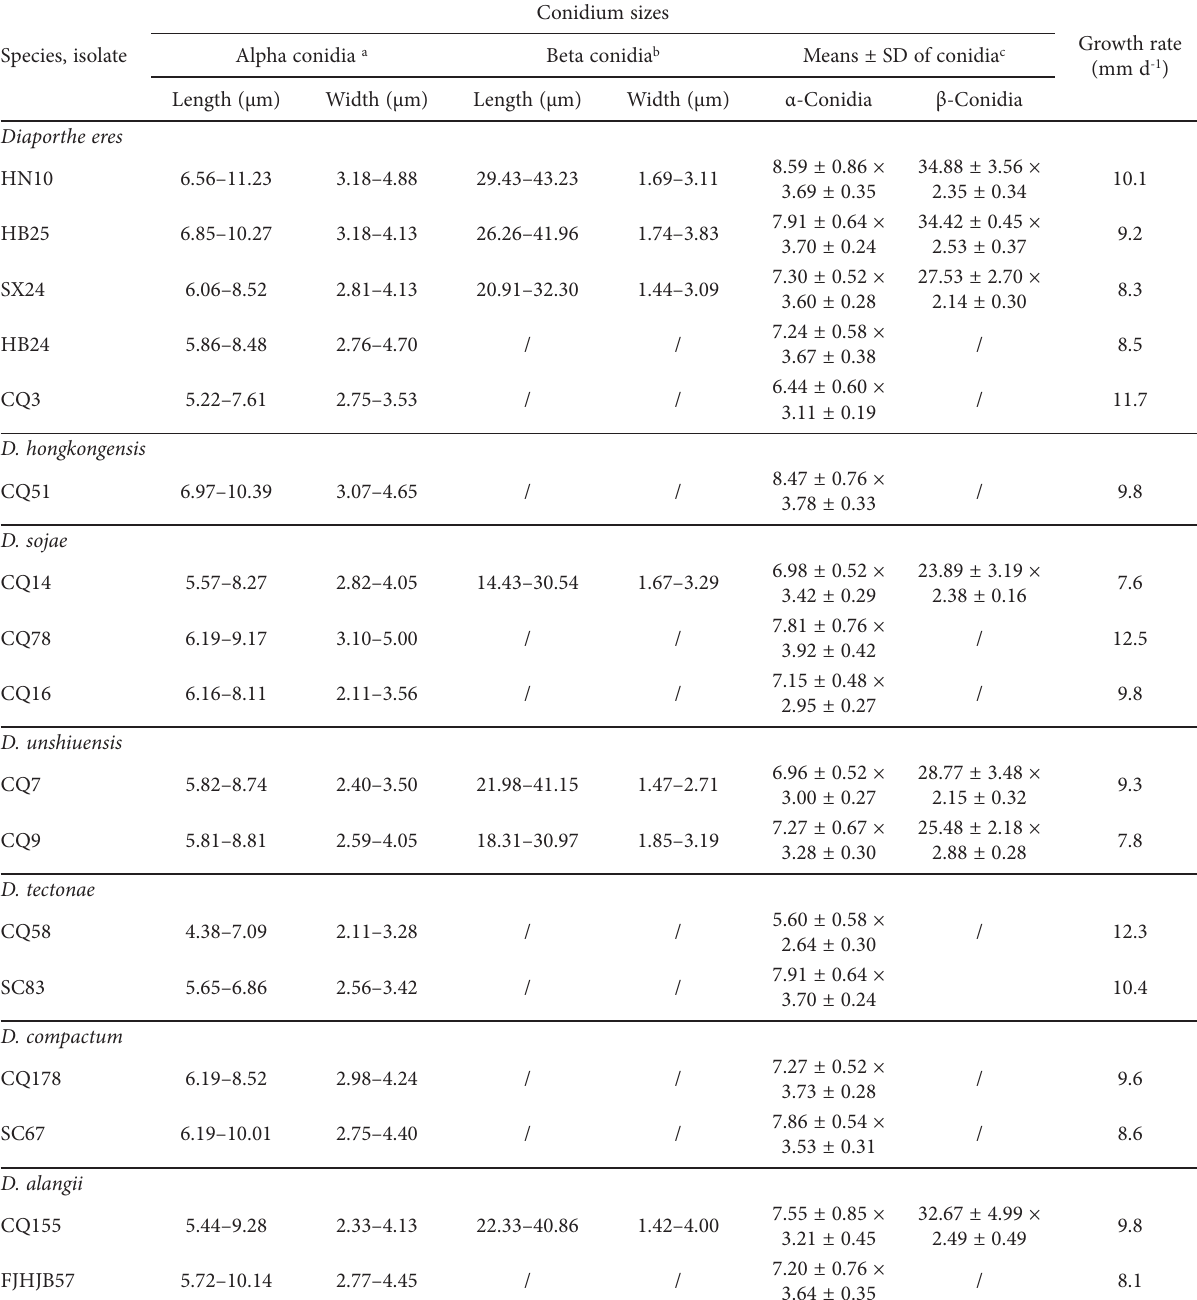
Table 3. Sizes of alpha and beta conidia, and growth rates in culture, of representative isolates of Diaporthe spp. obtained in this study.